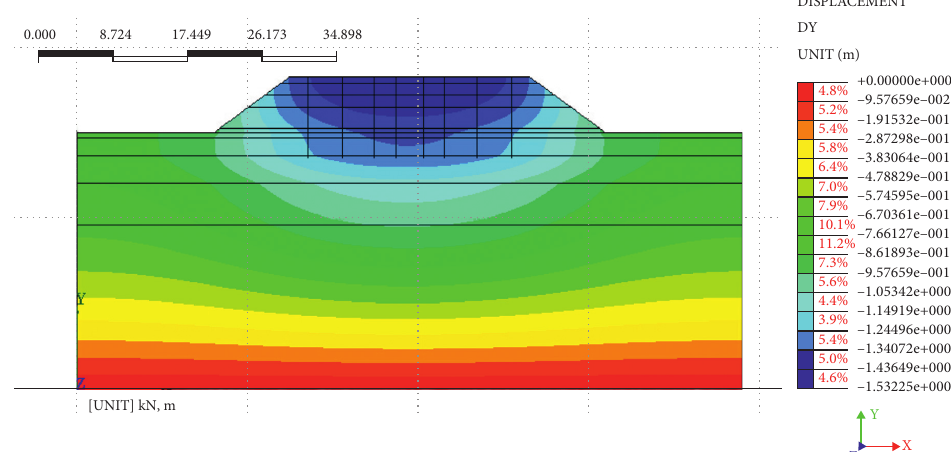
Figure 6: Model results for vertical displacement during roadway operation.